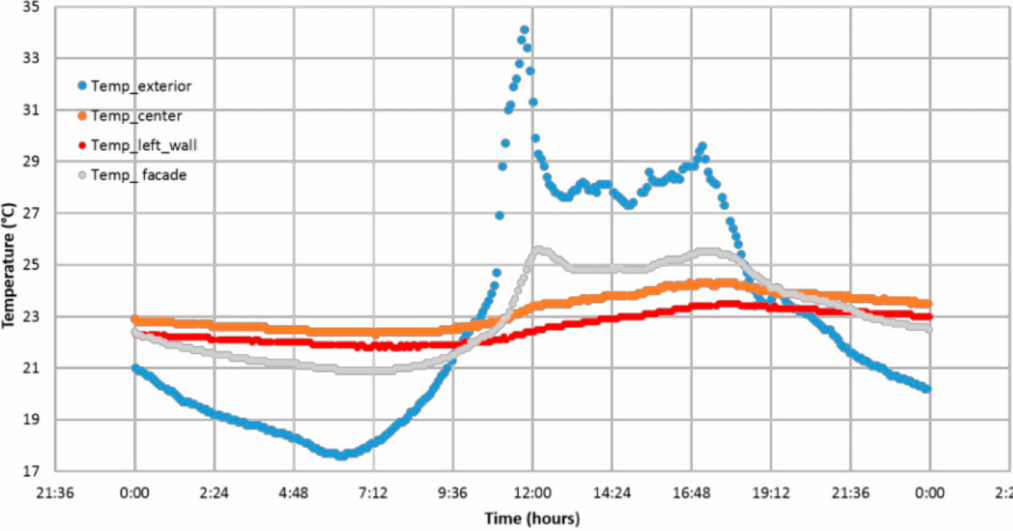
Figure 1. Temperature variation on a summer